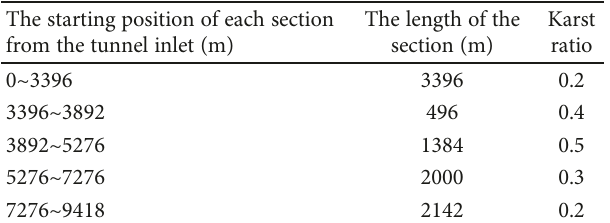
Table 4: Simulation